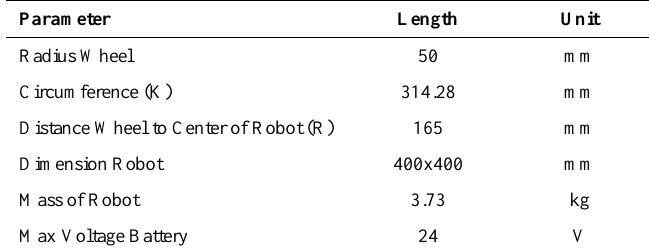
Table 2. Robot and Wheel Parameter